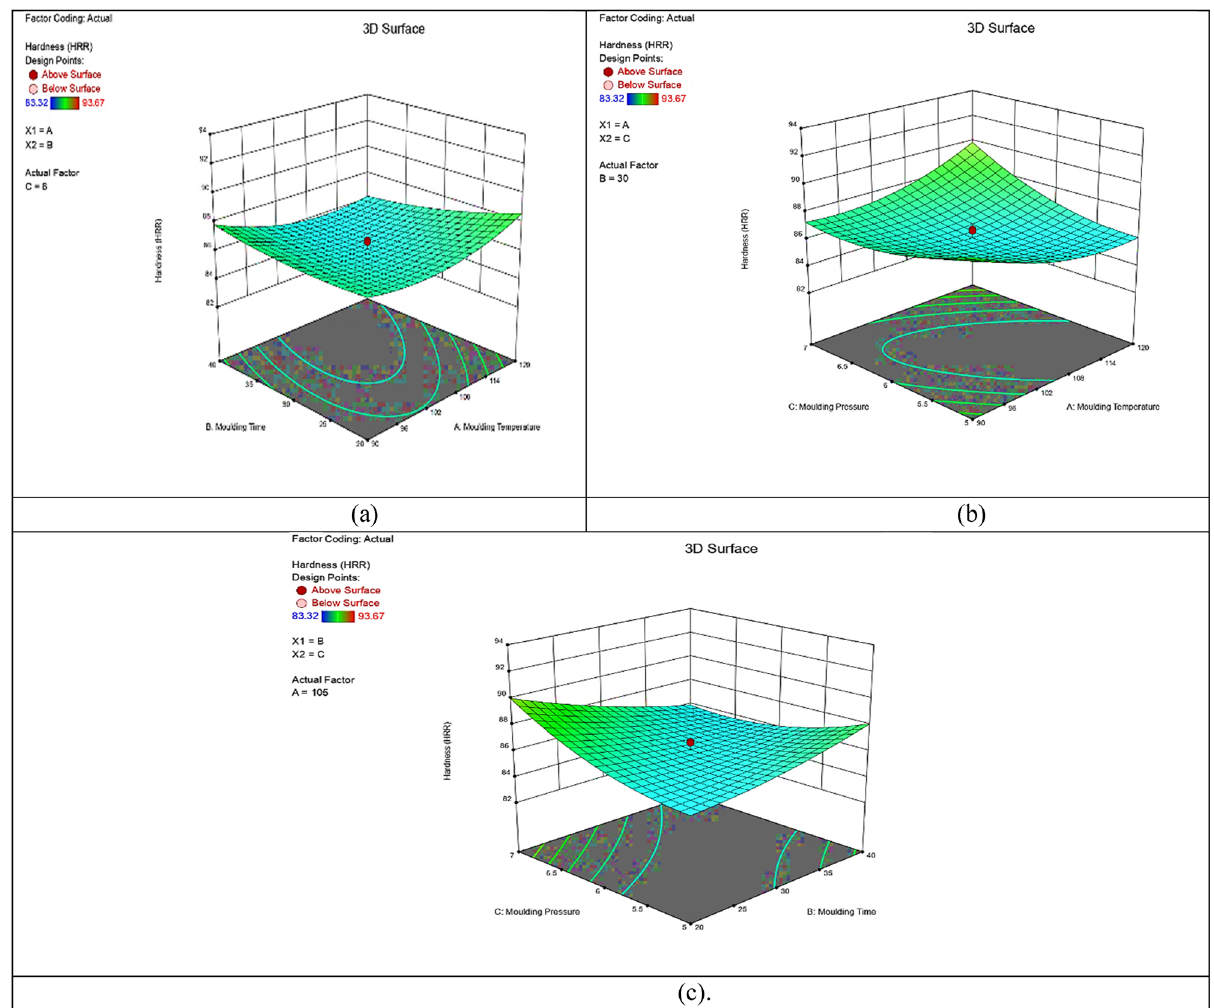
Figure 22: ( a – c ) 3D interaction plots for the hardness of leather bu ffi ng dust reinforced recycled EVA polymer